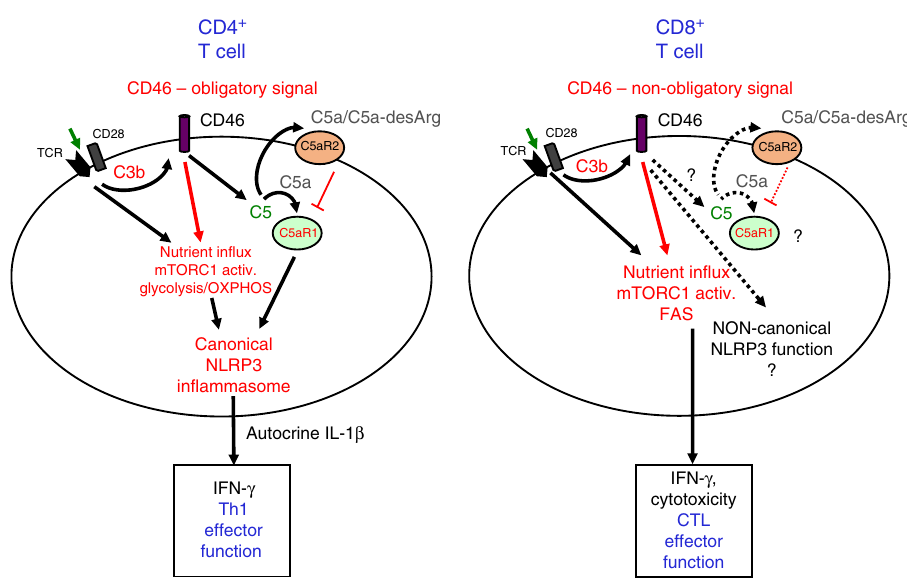
Fig. 7 Model of complosome and in fl ammasome roles in CD4 + and CD8 + T cells. TCR and CD28 stimulation-induced C3b generation mediates autocrine CD46 stimulation in both T-cell types. This is an obligatory event for Th1 effector function induction while CD46 engagement is a superior co-stimulator on CD8 + T cells. In both cases, CD46 functions through mediating nutrient in fl ux and augmentation of key metabolic pathways. Whereas a canonical